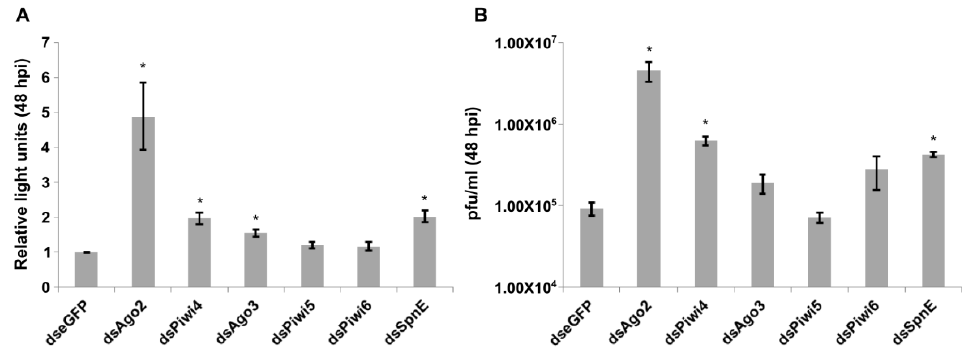
Figure 2. Effect of gene silencing on CHIKV replication. ( A ) Aag2 cells were transfected with dsRNAs to silence indicated transcripts, infected with CHIKV-2SG-FFLuc at 24 h pt, and lysed at 48 hpi. FFLuc activities were determined and are presented as relative mean luciferase activity values (normalized to activity in dseGFP treated). The error of the mean from three experiments conducted in triplicate are shown; ( B ) cells transfected as described above were infected with wt CHIKV at MOI of 0.01, and media was harvested 48 hpi, followed by plaque titration. The mean values of four independent experiments with standard deviation are shown. * indicates significance, p < 0.05 (Student’s t -test).